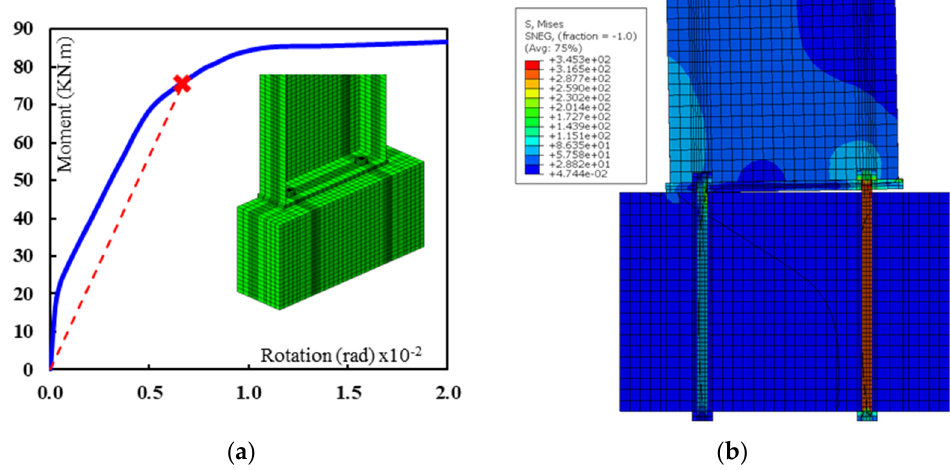
Figure 11. Specimen B4-D18-S050-T18: ( a ) moment–rotation curve, ( b ) deformed shape–von misses stress at H/150 column drift.